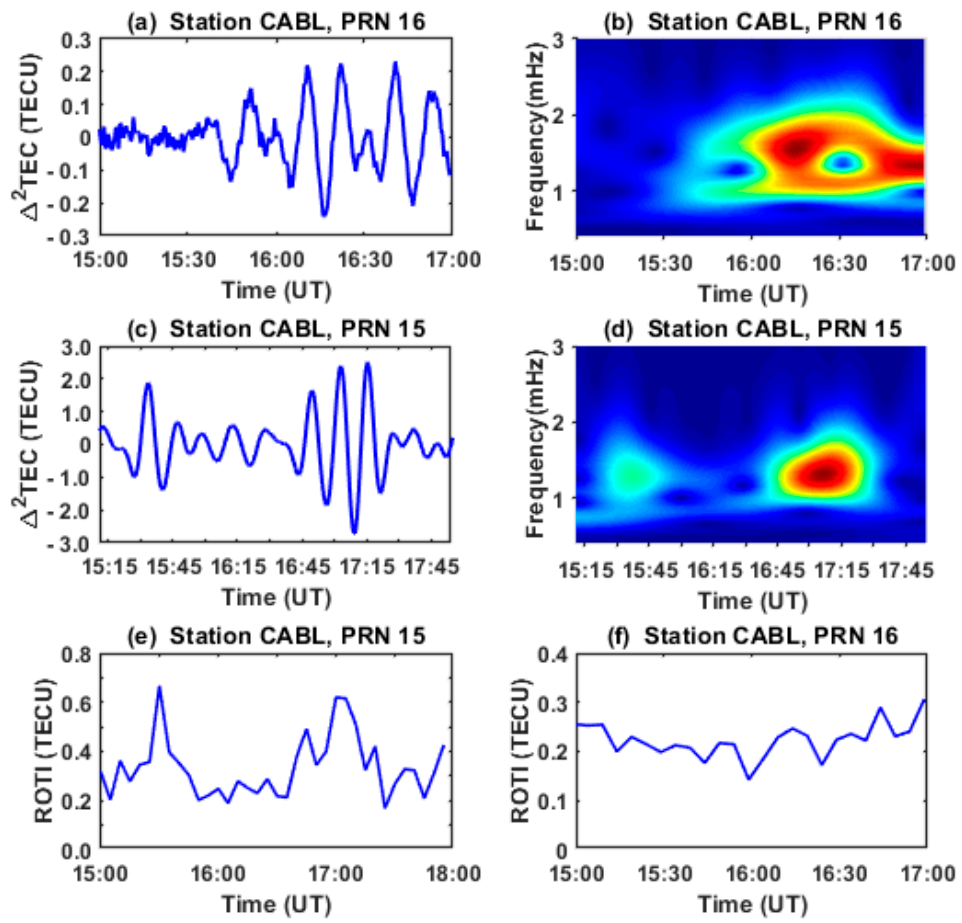
Figure 12. Time series for PRN16 ( a ) and PRN15 ( c ) observed from GPS station CABL. ( b ) and ( d ) the time-frequency analysis for the ∆ 2 TEC time series. ROTI time series for PRN16 ( e ) and PRN15 ( f ) observed from GPS station CABL on 11 March 2011.